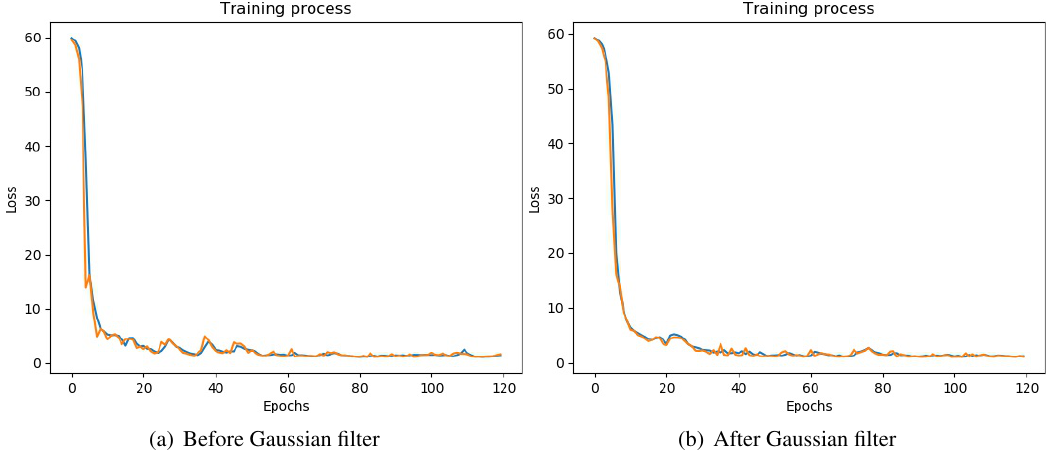
Fig. 6 Training process of RSOA. RSOA, reference signal optimisation